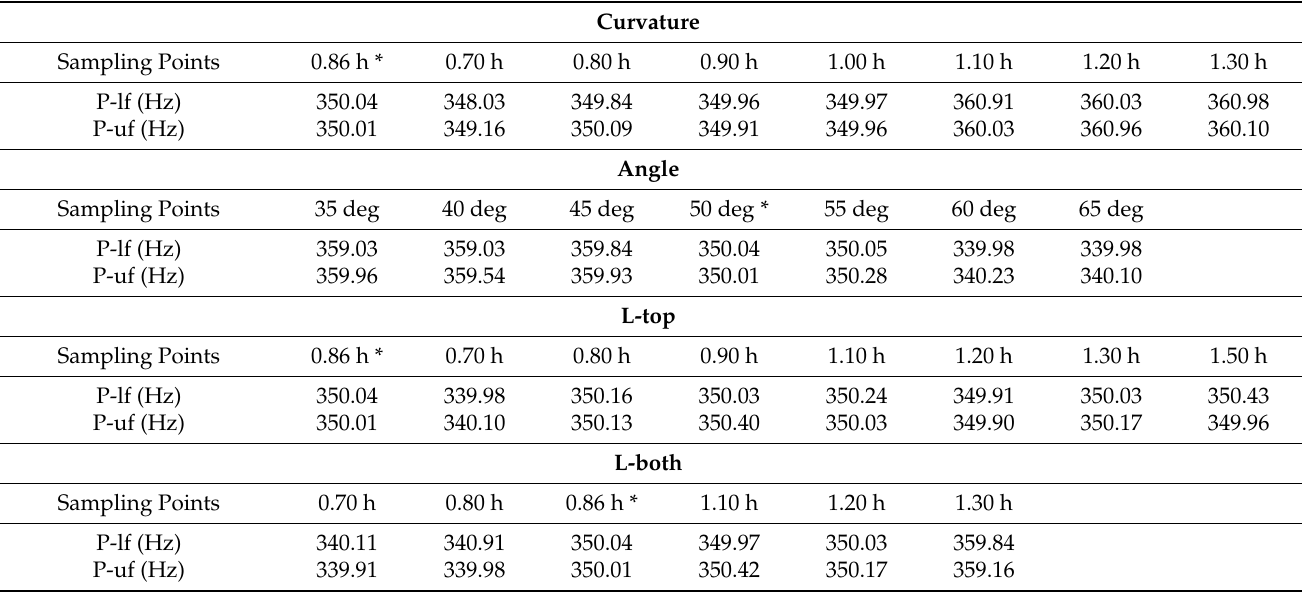
Table 3. Oscillation frequency for different cases at the upper and lower feedback